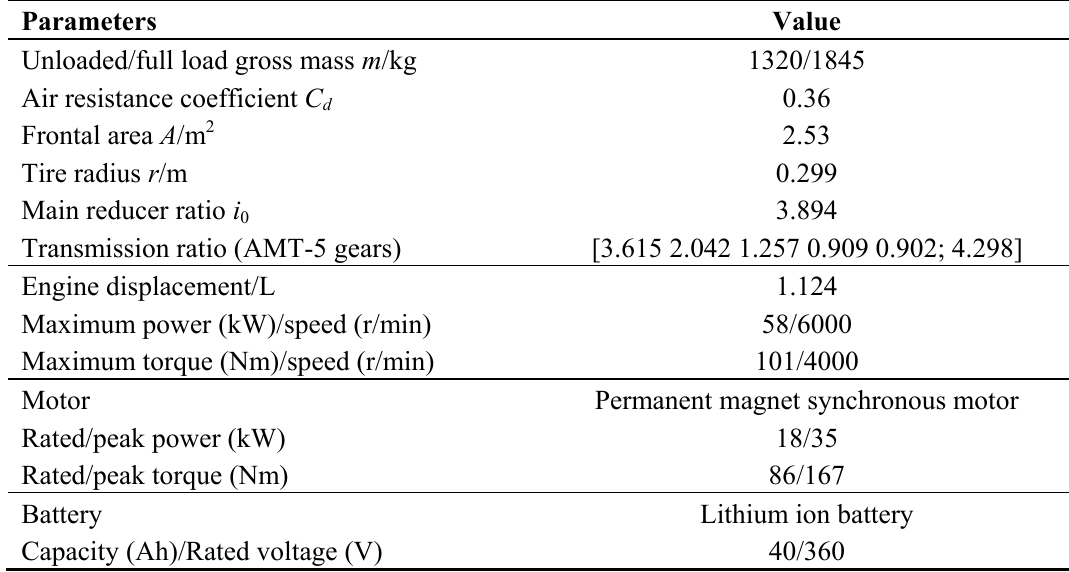
Table 1. The vehicle and powertrain